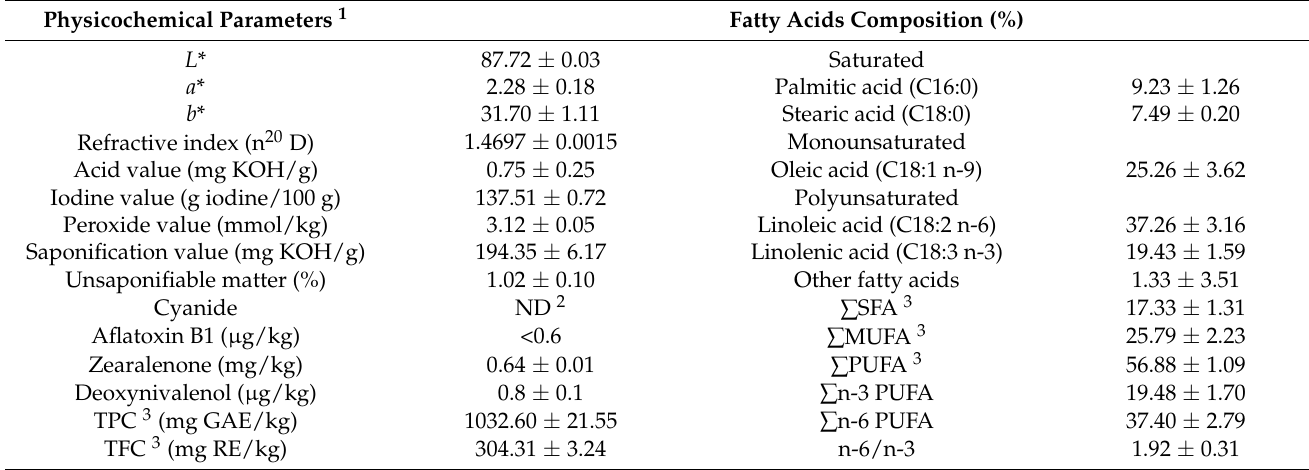
Table 1. Physicochemical characteristics of